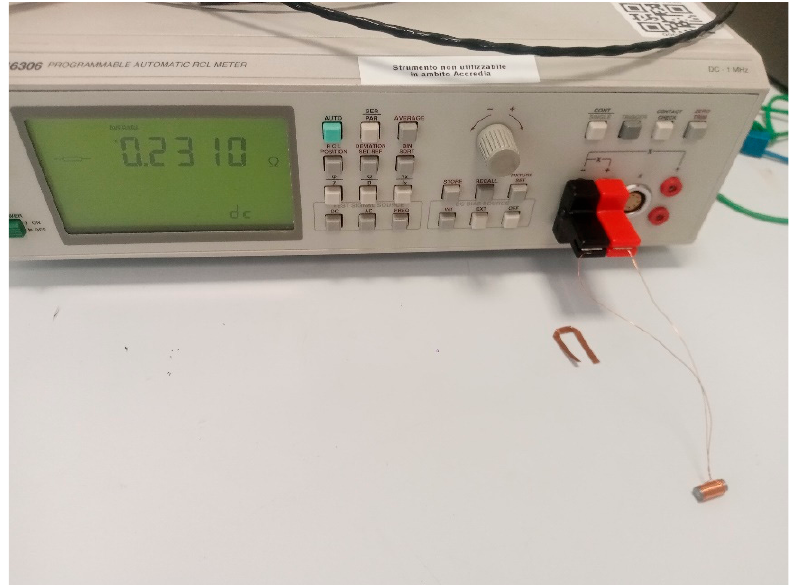
Figure 12. RCL measurement setup: detection of the DC resistance value.